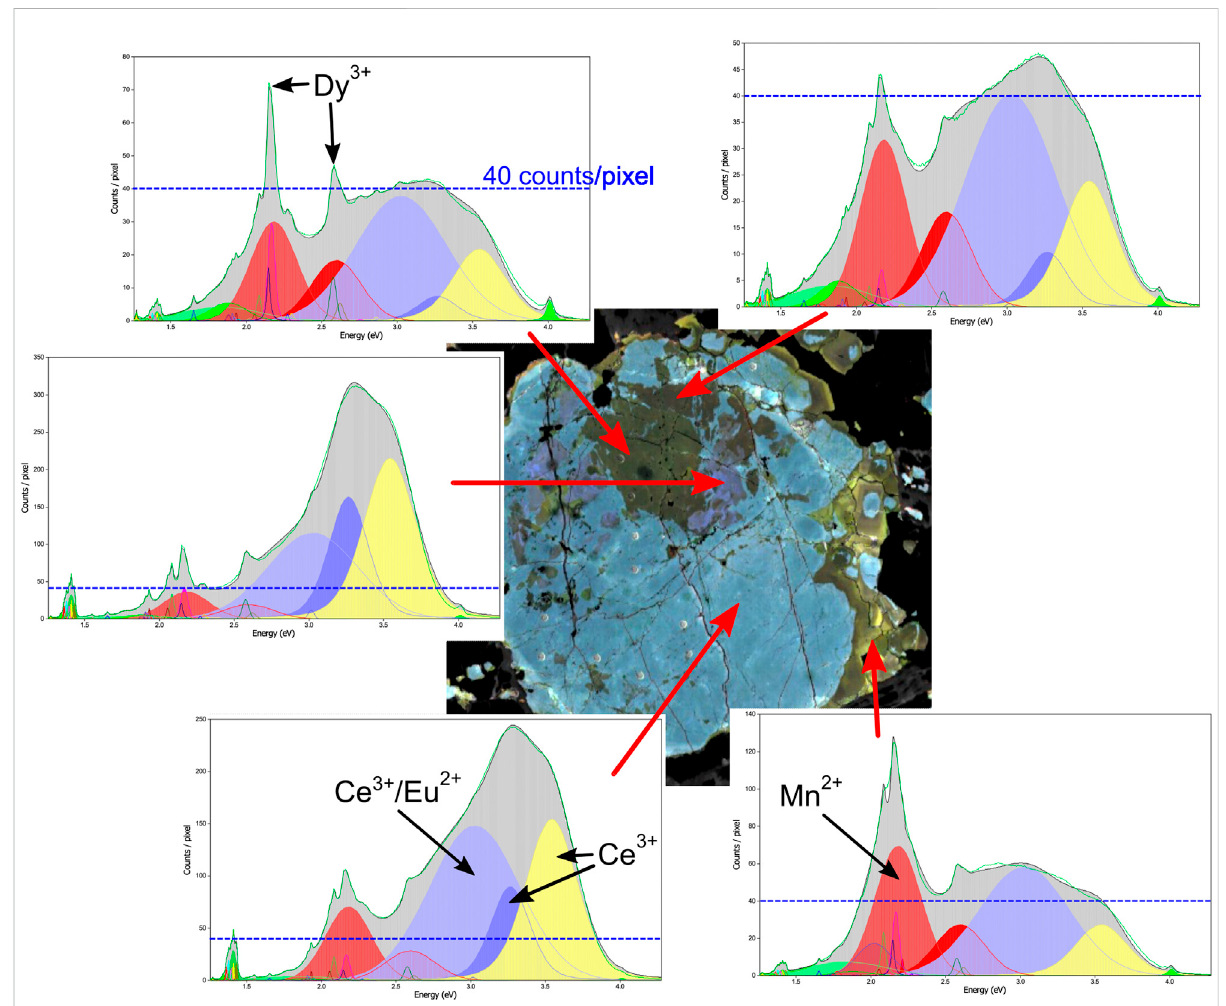
FIGURE 5 Example spectra for different regions in sample MMA2-122.75. Blue dashed lines show 40 counts/pixel intensity level in different spectra for comparison. Theuppercenterofthegrainischaracterisedbylow CLintensityin2 – 4eV rangeandlowoverall CLemission,whichisuptoafactorof 8 higher in the surrounding regions. The outer rim areas show a strong Mn 2+ peak at 2.2 eV. The sharp Dy 3+ and Sm 3+ emissions do not have a pronounced effect in the mixed RGB